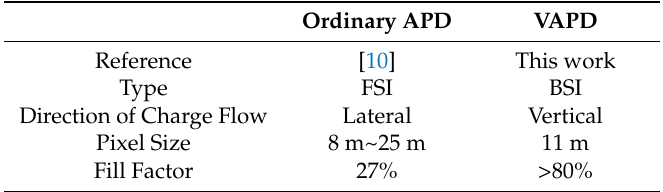
Table 1. Comparison of ordinary APD and VAPD.